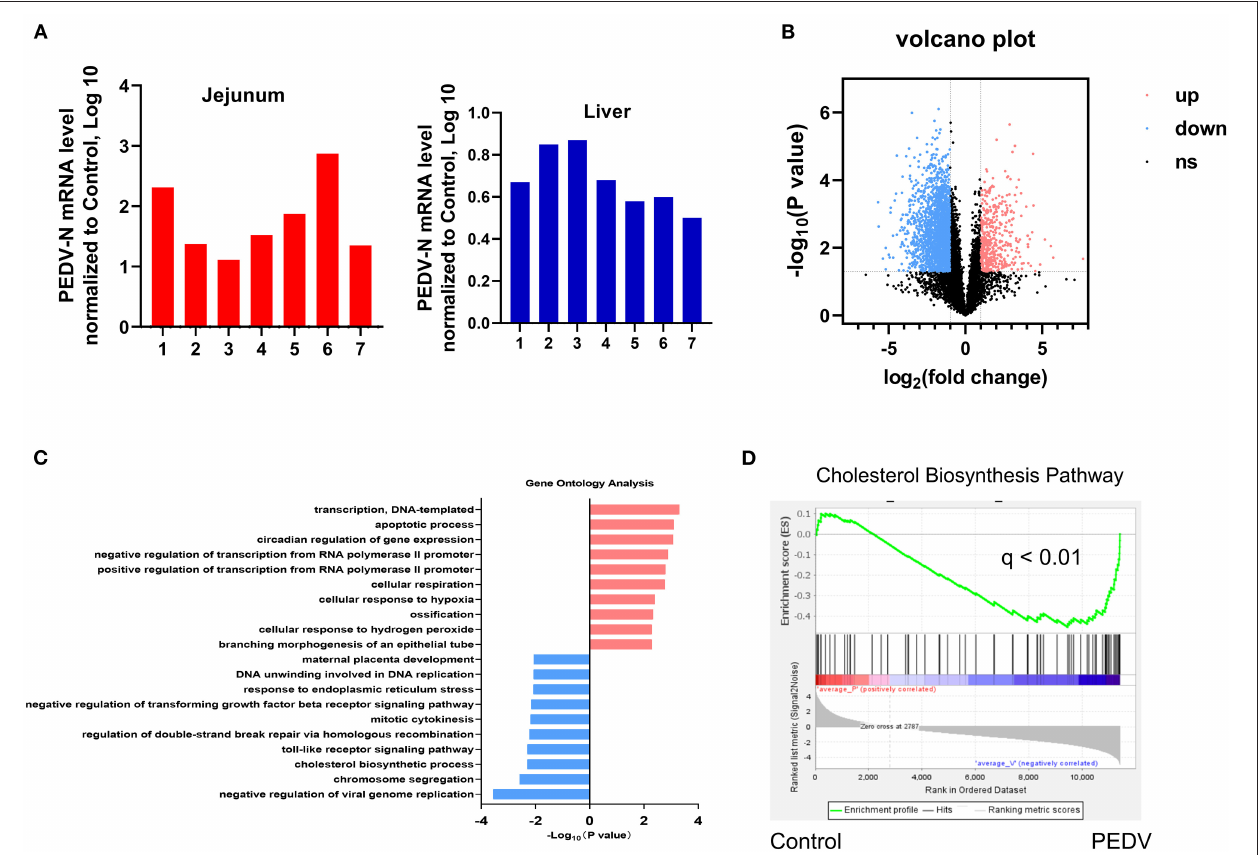
FIGURE 1 | Cholesterol metabolism was modulated by Porcine epidemic diarrhea virus (PEDV) infection indicated by transcriptional profiling of piglet livers. (A) PEDV RNA expression was determined by Quantitative Real-Time PCR (qRT-PCR) analysis in the jejunum and liver tissues of PEDV-infected and control piglets. (B) Volcano plot visualization of the hepatic transcriptome measured by RNA-seq analysis. (C) Genes involved in the cholesterol biosynthesis pathway were among the most enriched pathways based on gene ontology (GO) analysis. (D) The gene-set enrichment analysis (GSEA) plot of the differentially expressed genes in the cholesterol biosynthesis pathway of livers from PEDV-infected piglets compared to the controls. False-discovery rate (FDR).